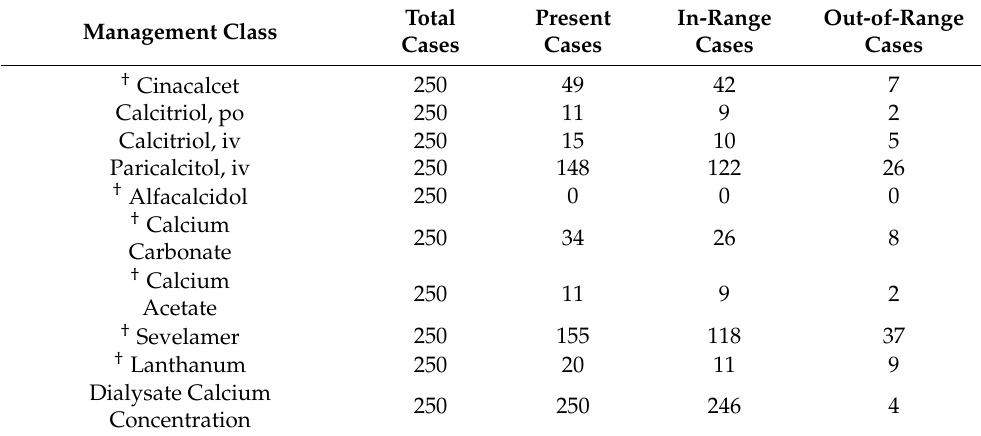
Table 8. Concordance evaluation for the medication dosage